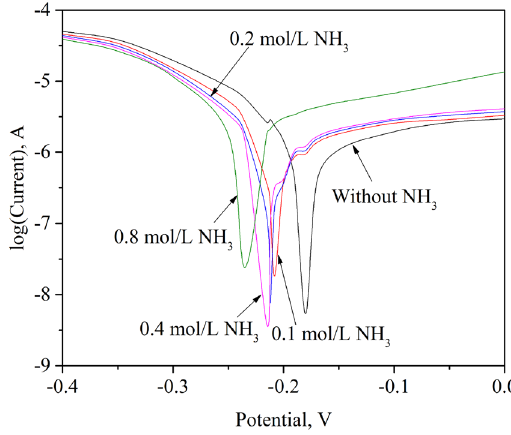
Figure 3: Tafel plots of gold dissolution with di ff erent ammoniacal